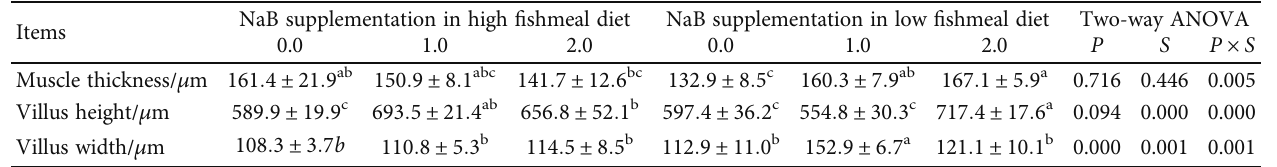
Table 7: E ff ect of dietary sodium butyrate on intestinal histology of rainbow